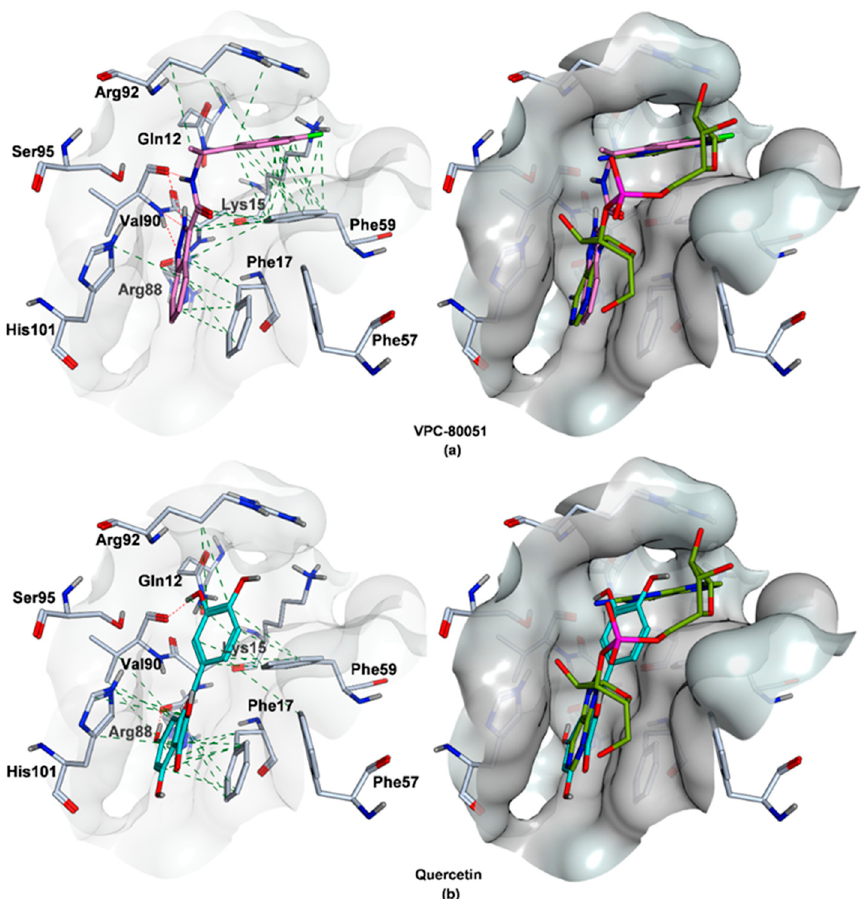
Figure 4. ( a ) Left. Predicted binding pose of VPC-80051 within the hnRNP A1 RBD pocket. VPC-80051 is shown in stick representation (magenta = carbon, blue = nitrogen, red = oxygen, green = fluorine). Interacting residues are shown as sticks and colored in light blue-grey. The pocket surface is colored in light grey. Hydrogen bonds formed by VPC-80051 with the backbone amide and carbonyl of Val90 are indicated with red dashed lines. Hydrophobic interactions with aromatic rings of Phe17, His101 and Phe59 as well as with aliphatic side-chains of residues shaping the pocket are indicated with green dashed lines; Right. Significant structural overlap between VPC-80051 and nucleobases of the 5 (cid:48) -AG-3 (cid:48) RNA within the hnRNP A1 RBD pocket; ( b ) Left. Predicted binding pose of quercetin. Hydrogen bonds formed with Val90 and Arg88 backbone carbonyls are indicated with red dashed lines; Right. Structural overlap between quercetin and the 5 (cid:48) -AG-3 (cid:48) RNA. Minimal overlap with the guanine base. VPC-80051 chemical name: ( N -[(1S)-1-(3,4-difluorophenyl)ethyl]-1 H -indazole-3-carboxamide). Quercetin